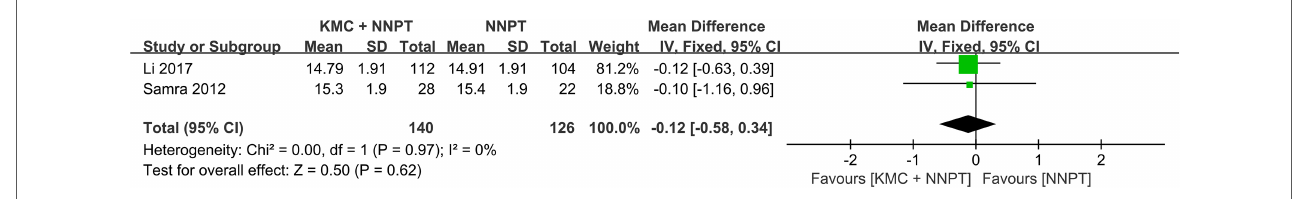
FIGURE 3 Forest plot comparing KMC+NNPT with NNPT alone on peak bilirubin in neonates with non-pathological jaundice.